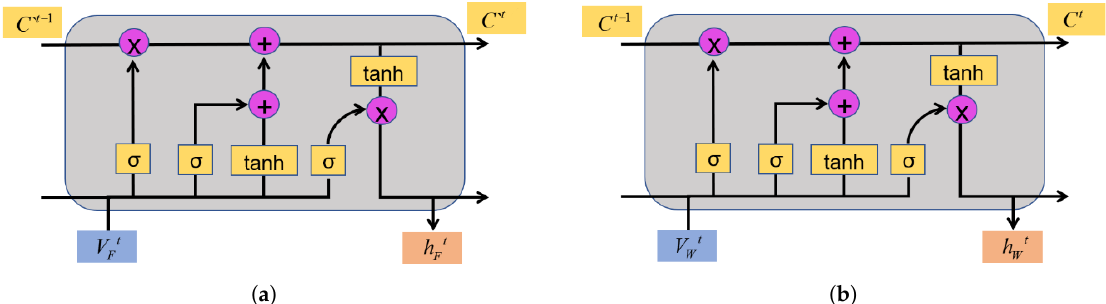
Figure 3. Neuron unit structure of the normal LSTM based model. ( a ) The main neuron unit for predicting fire spread rate. ( b ) The accessory neuron unit for predicting wind